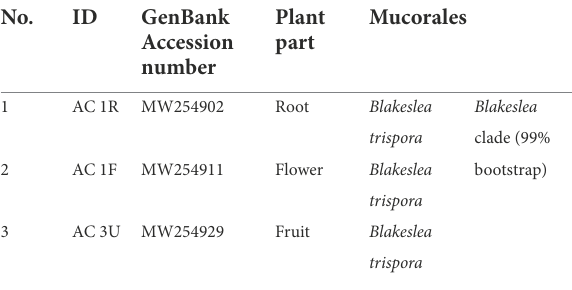
TABLE 4 Endophytic fungal order from the phylum